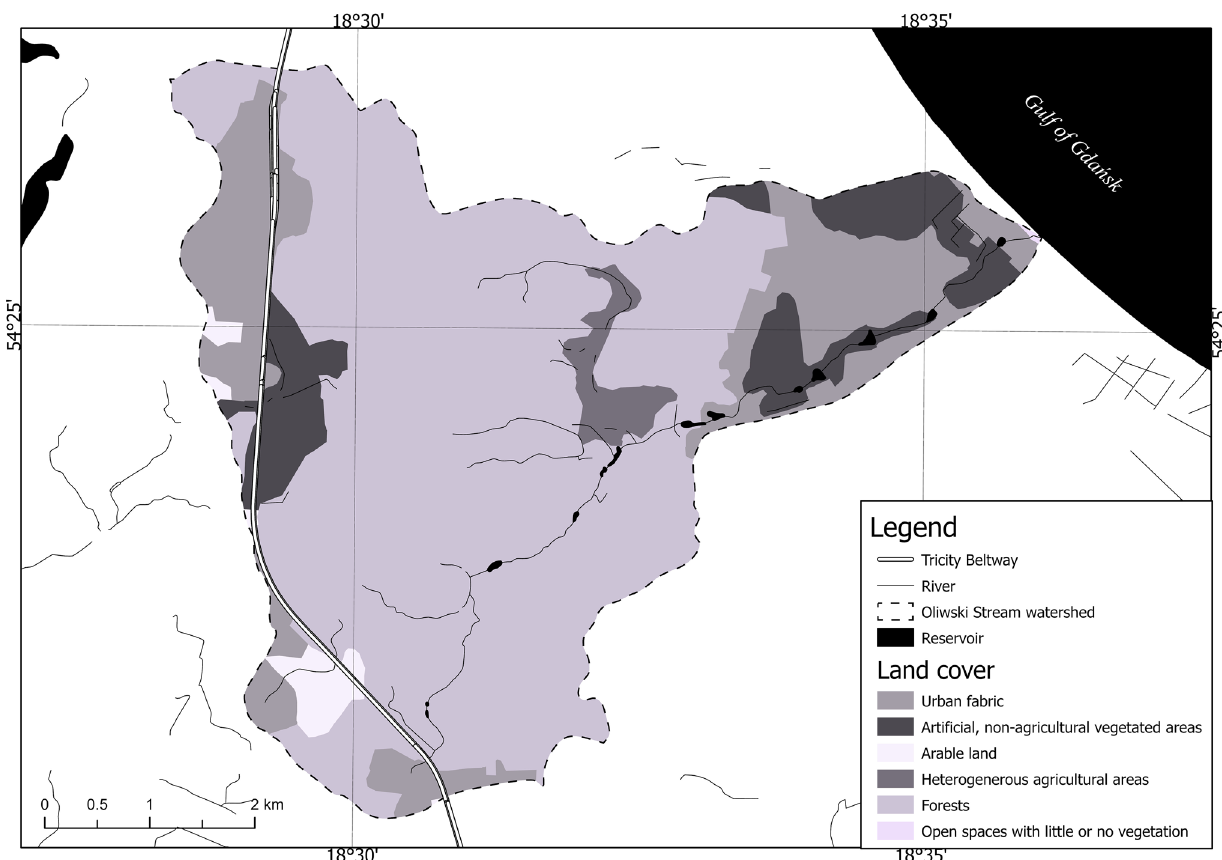
Fig. 3 Structure of use of area in Potok Oliwski catchment (Major and Cieśliński